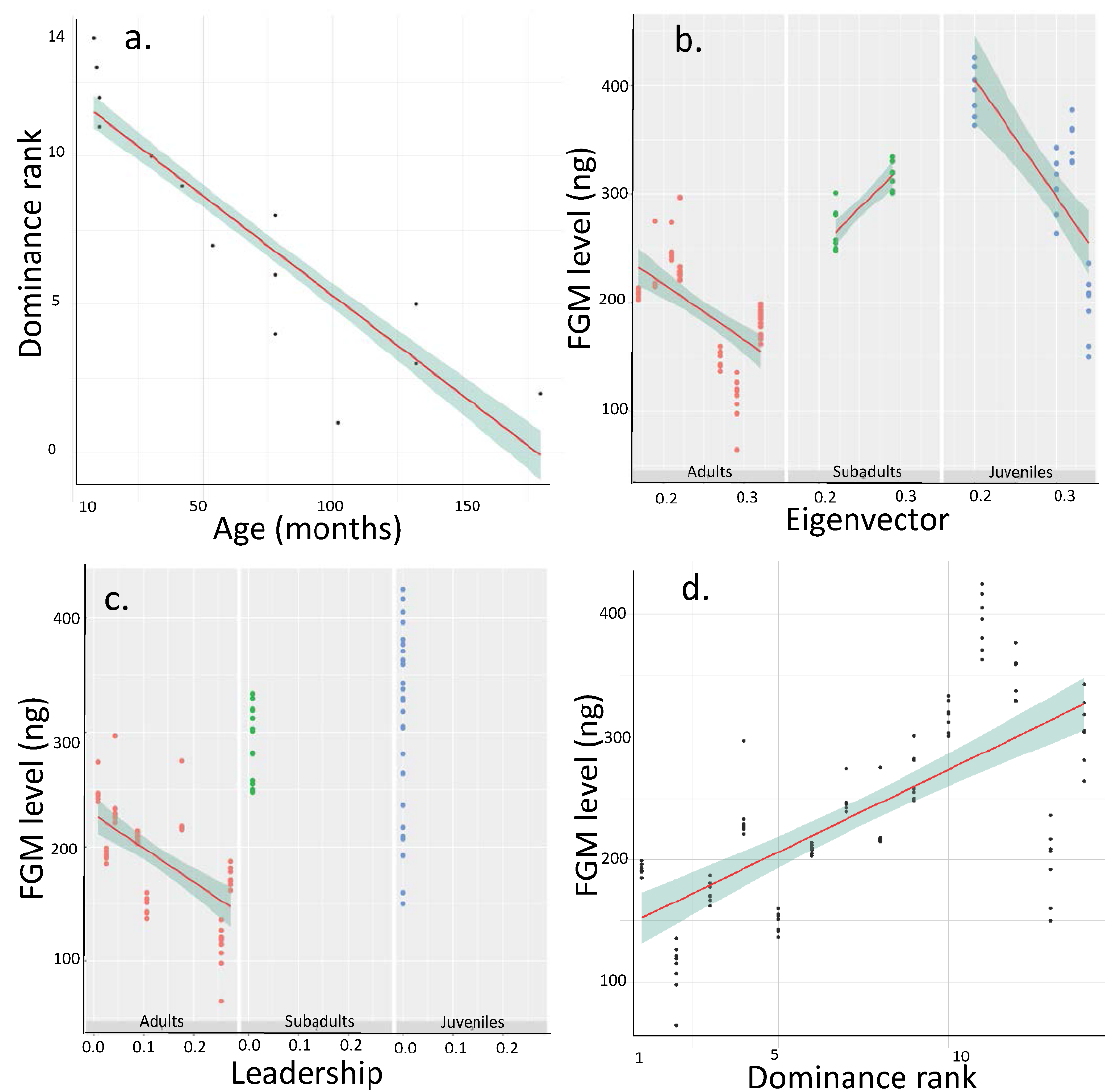
Figure 1. Main effects obtained between faecal glucocorticoid metabolites (FGM, ng/g-1) and social status in European bison. ( a ) Dominance in function of Age, ( b ) FGM concentration in function of Eigenvector (arbitrary unit) and Age (months), ( c ) FGM concentration in function of leadership (relative frequency) score and Age, ( d ) FGM concentration in function of dominance rank. Higher rank individual is ranked 1 whilst lower rank individual is ranked 14.